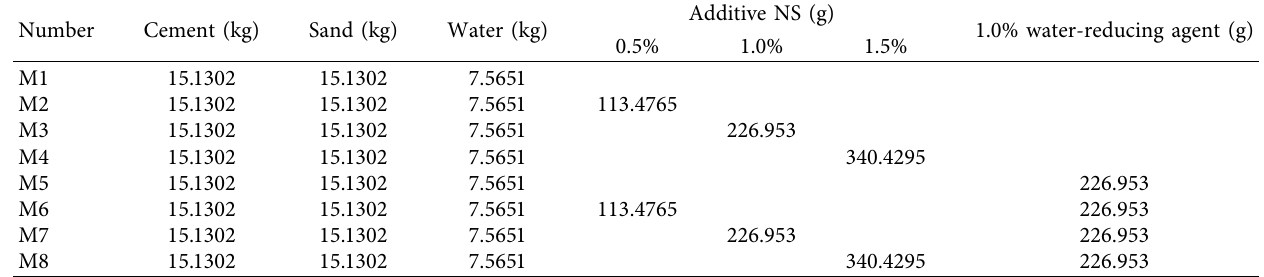
Table 2: Composition of the mortar mixture.